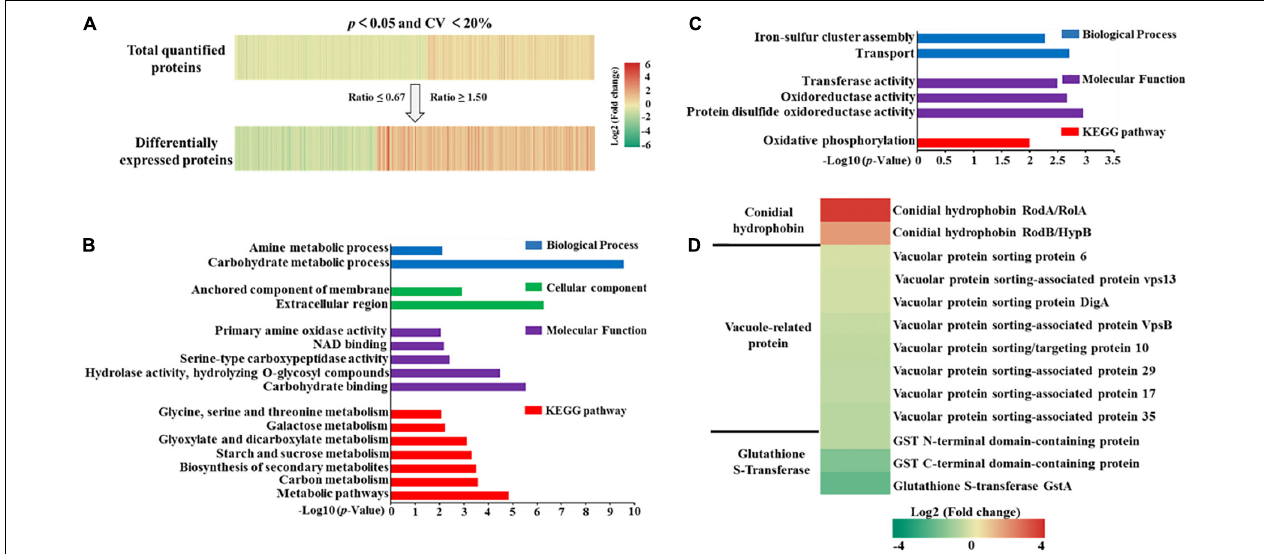
FIGURE 3 | (A) Heatmaps of quantified proteins (top) and differentially expressed proteins (bottom). (B) Gene ontology and Kyoto Encyclopedia of Genes and Genomes pathway enrichment of up-regulated proteins. (C) Gene ontology and Kyoto Encyclopedia of Genes and Genomes pathway enrichment of down-regulated proteins. (D) Heatmap of some vital proteins related to aflatoxin production.